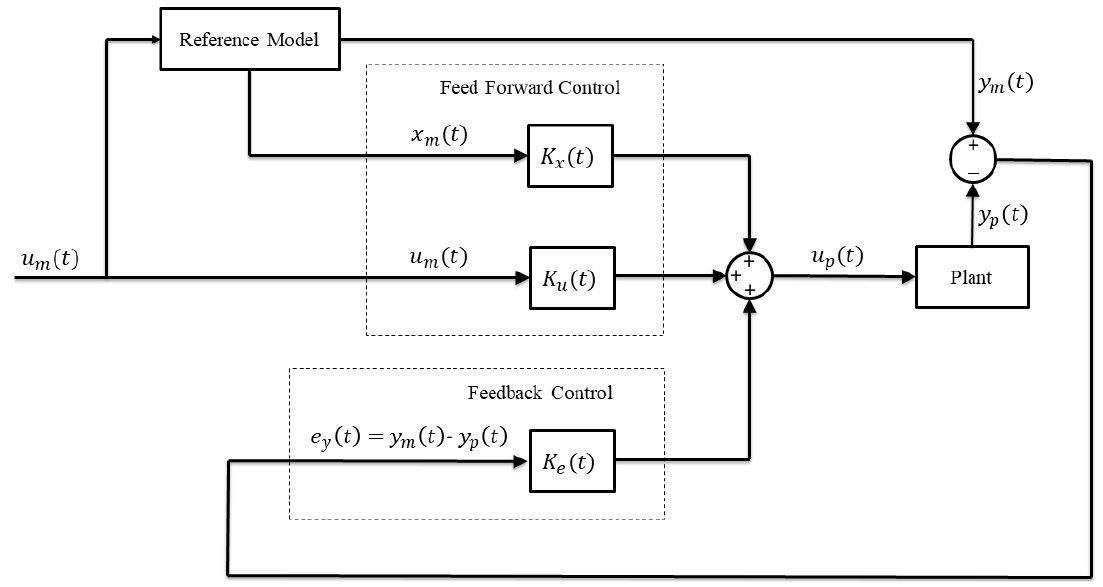
Figure 3. Adaptive control structure.